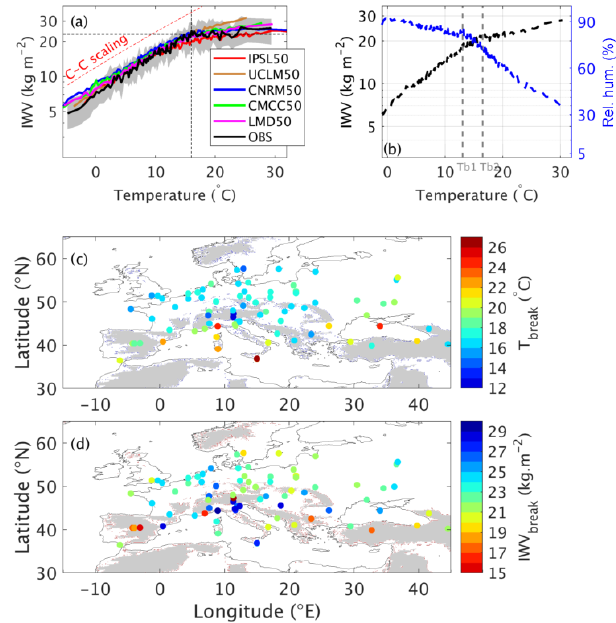
Figure 5. (a) IWV– T (2m) relationship at SIRTA station from ob- servations and models. Median values are plotted for observations and models. The grey band represents the interval between the 20th and 80th quantiles for observations. The black vertical dashed line shows T break , the black horizontal dashed line shows IWV break , and the red slant dashed line shows C-C scaling. (b) Median values of IWV and RH(2m) as a function of T (2m) at SIRTA from obser- vations only. The vertical grey dashed lines indicate the values of Tb1 and Tb2 (see Sect. 4). (c) Map of T break at all the GPS stations. (d) Map of IWV break at all the GPS